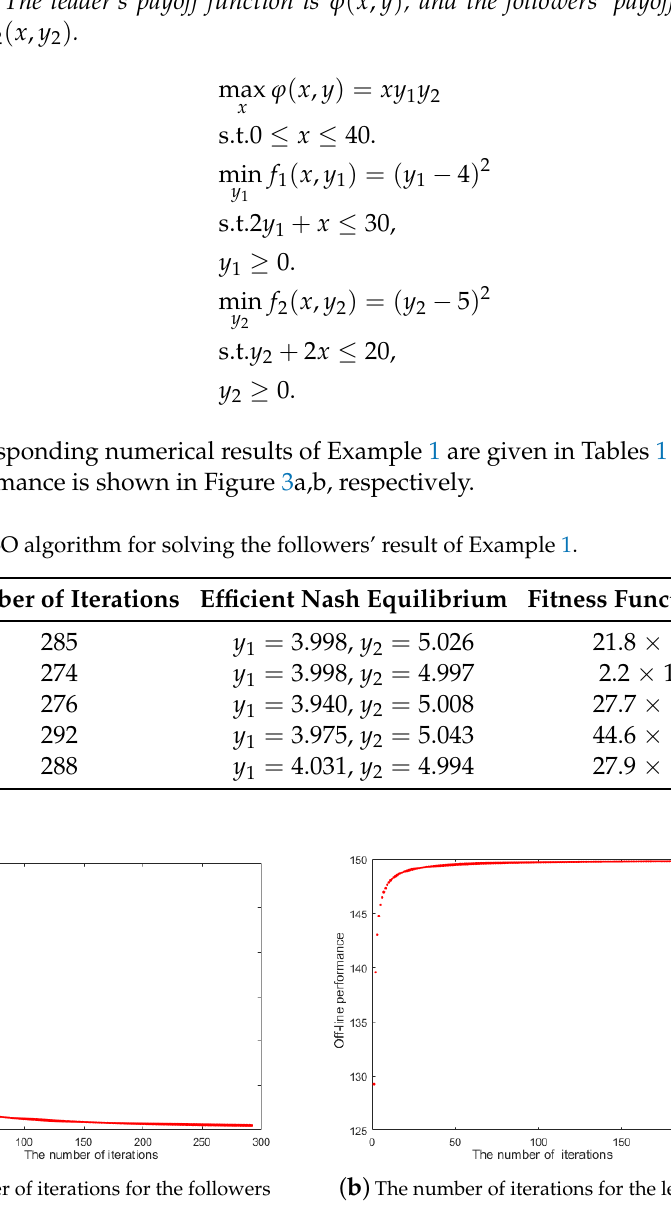
Figure 3. Off-line performance of the followers and leader for the IPSO algorithm. Table 2. The IPSO algorithm for solving the leader’s result of Example